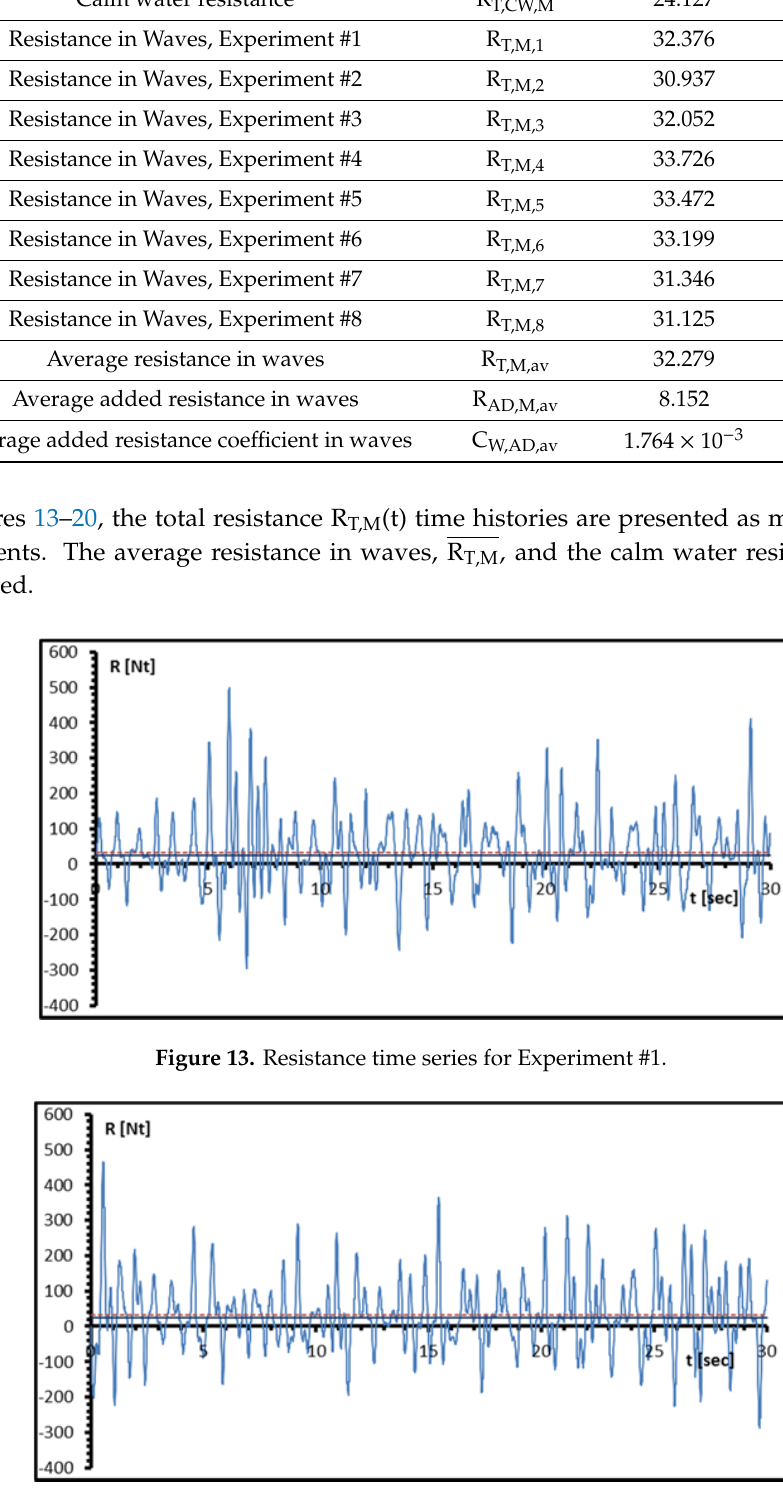
Table 5. Model scale resistance measurements.